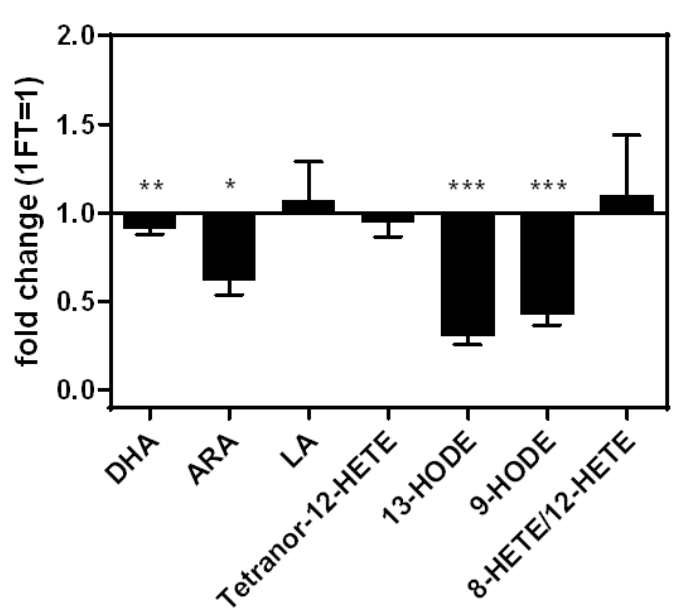
Figure 4. Fold changes of analyte concentrations comparing two freeze–thaw cycles relative to one freeze–thaw cycle. Measurements performed as triplicates. Statistics: unpaired Student’s t -test, p ≤ 0.05 (*), p ≤ 0.01 (**), p ≤ 0.001 (***). ARA—arachidonic acid; BHT—butylated hydroxytoluene;